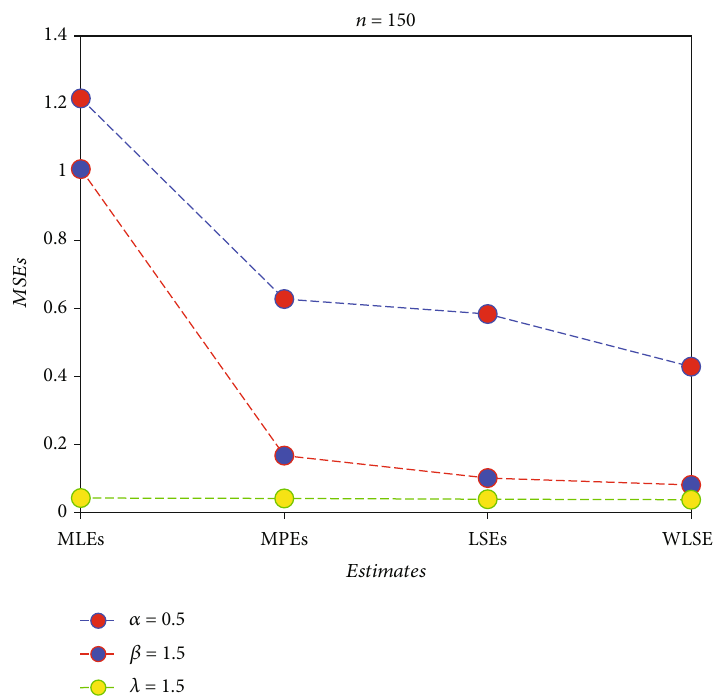
Figure 8: MSEs using n = 150 : α = 0 : 5 , β = 1 : 5 , and λ = 1 : 5 .